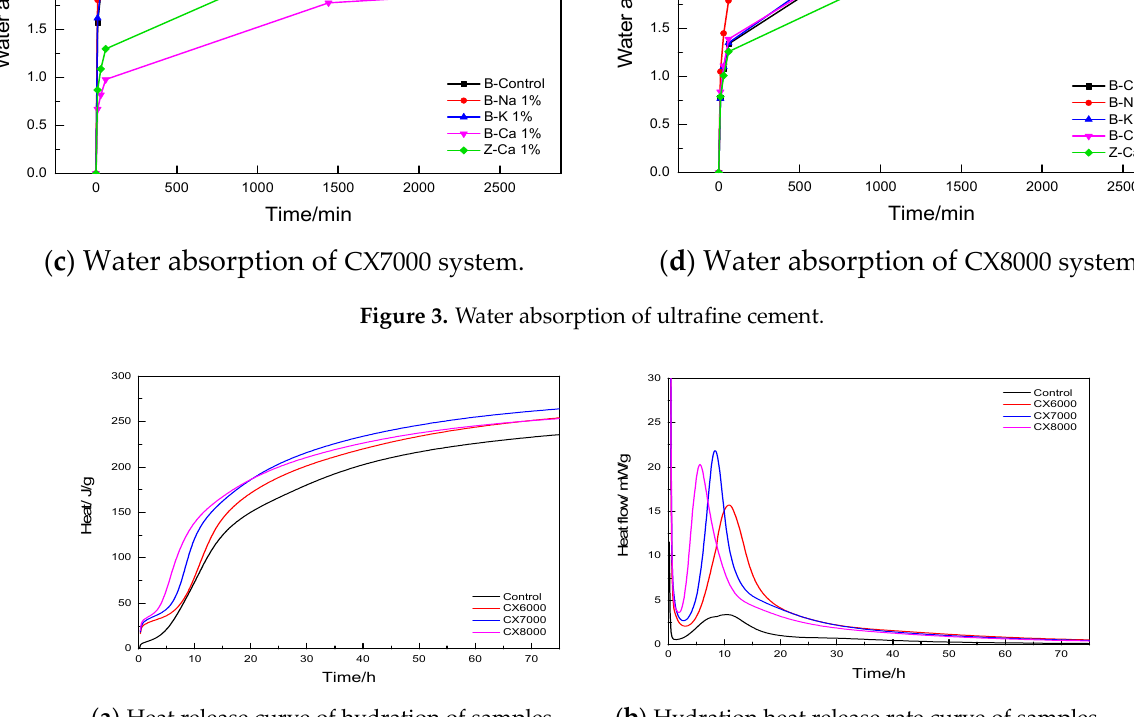
( b ) Hydration heat release rate curve of samples. Figure 4. Heat of hydration curves of ultrafine cement. Figure 4. Heat of hydration curves of ultrafine